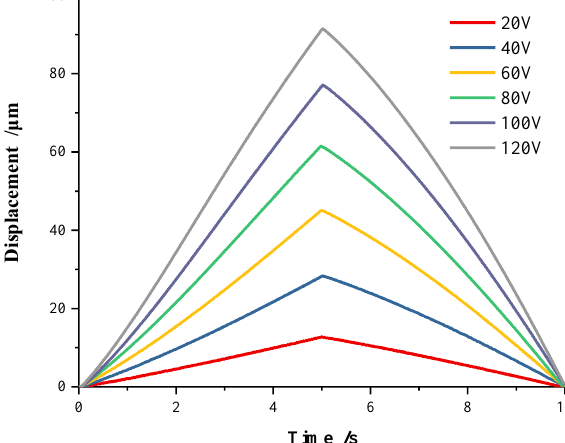
Figure 2. Hysteresis on variable voltage amplitudes (0.1 Hz).